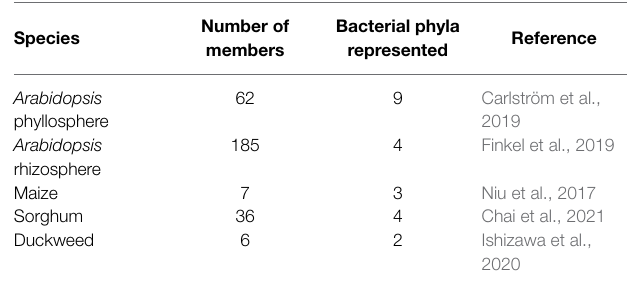
TABLE 1 | Highlighted synthetic microbial communities and community metabolic